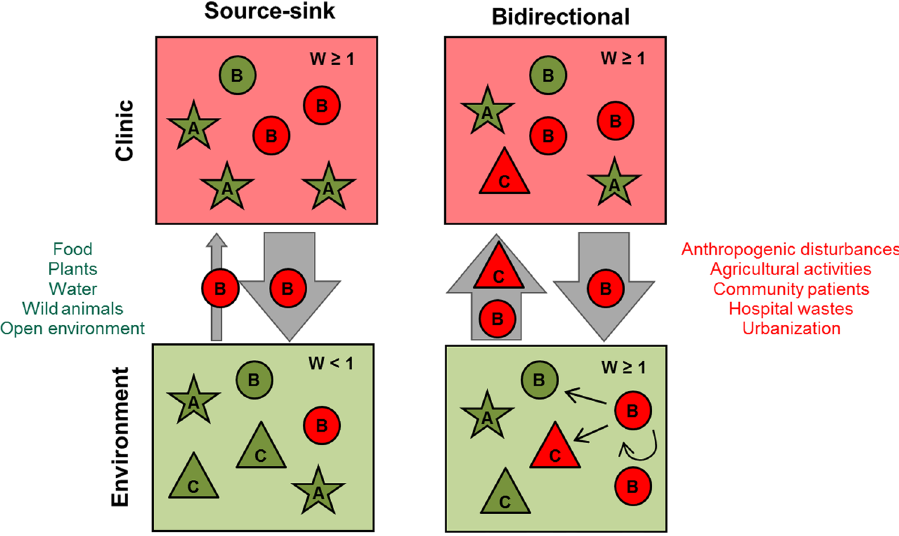
Figure 1. Two model systems of dissemination of antimicrobial resistance gene cassettes. In the source-sink model system there is a flow (grey arrow) from the clinic (source) to the open environment (sink). However, few events of recombination linked to antimicrobial resistance can be maintained in the environment (W < 1). In the bidirectional model system, clinical and environmental bacteria disseminate in both habitats. These bacteria from different niches can exchange and maintain antimicrobial resistance gene cassettes (ARGCs) (W ≥ 1) acquiring new phenotypes or not (Supplementary Table S1). Both the open environment and hospitals act as a reservoir and source of ARGCs able to deal with antibiotic pressure, while integrons modulate this exchange in part; arrows suggest possible ways of bacterial dissemination between settings. With the bidirectional model, the results are (i) a greater presence of ARGCs in the environment and in the clinical habitat, and (ii) the possibility that strains with new ARGCs penetrate in the hospital environment. Different shapes and letters represent distinct bacterial species or strains that can inhabit diverse micro-habitats. Red and green represent strains with or without ARGCs, respectively. Arrow width represents the amount of flux of resistant strains between